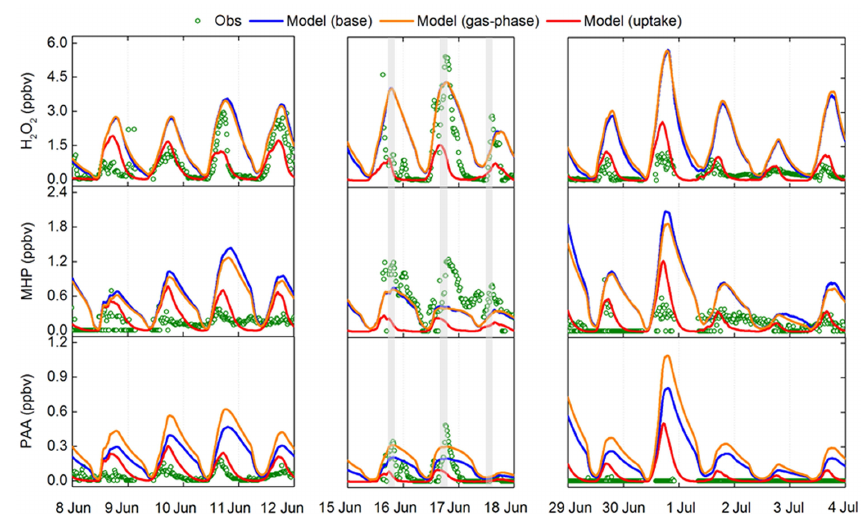
Figure 3. Observed and modeled concentrations of atmospheric peroxides for Phase I (8–11 June), Phase II (15–17 June) and Phase III (29 June–3 July). The green circles represent observed concentrations. The blue, orange and red lines indicate the modeled concentrations from three different scenarios: base case, new gas-phase reaction case and heterogeneous uptake case, respectively. The grey shaded area indicates three biomass burning